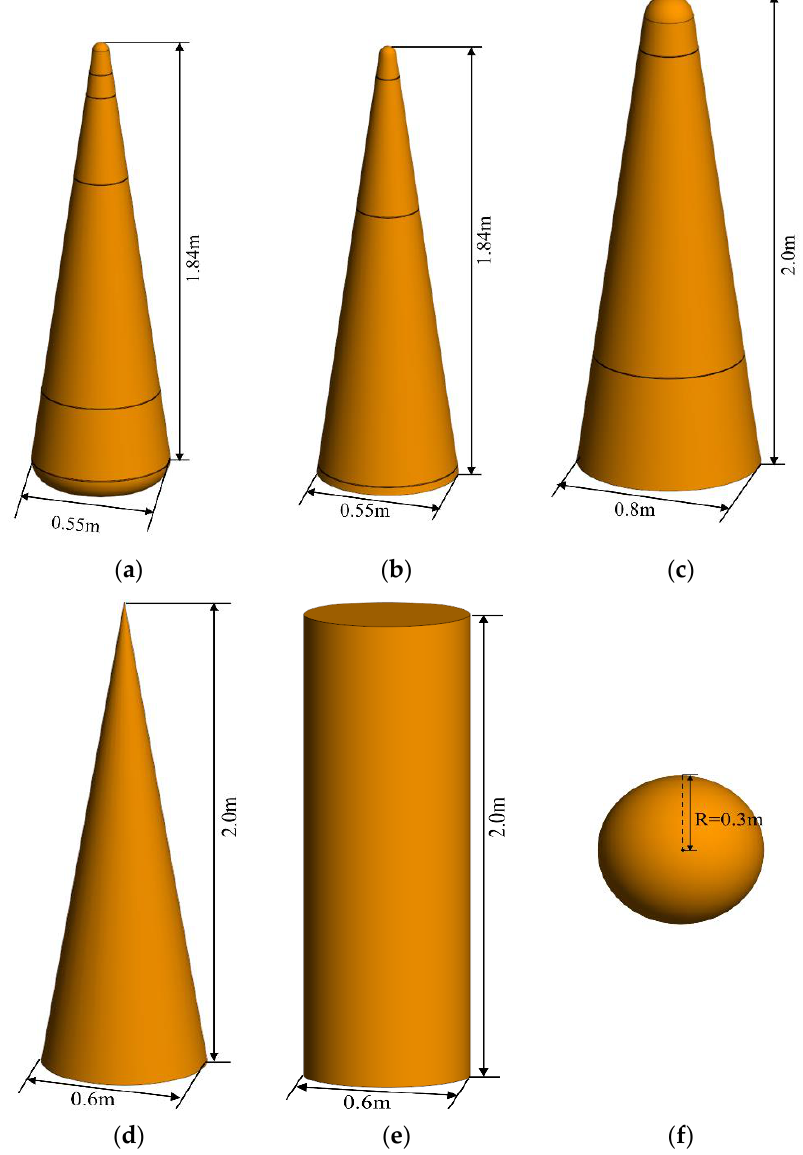
Figure 3. The geometric models of the six targets. ( a ) Warhead 1; ( b ) warhead 2; ( c ) warhead 3; ( d ) decoy 1; ( e ) decoy 2; ( f ) decoy 3. Table 1. Setting of the micro-motion parameters.